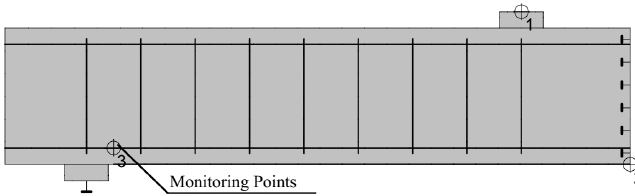
Figure 14. Position of monitoring points in the finite element model.